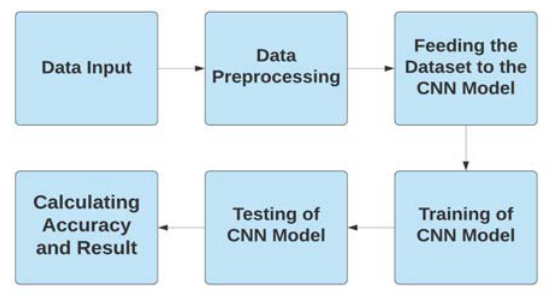
Fig.1. Flow Chart of Proposed